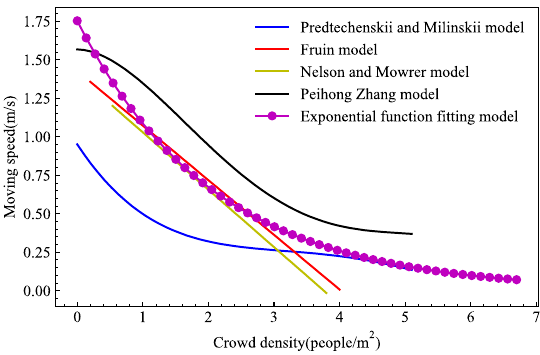
Figure 8. The fitting model of evacuees’ moving speed on straight paths.